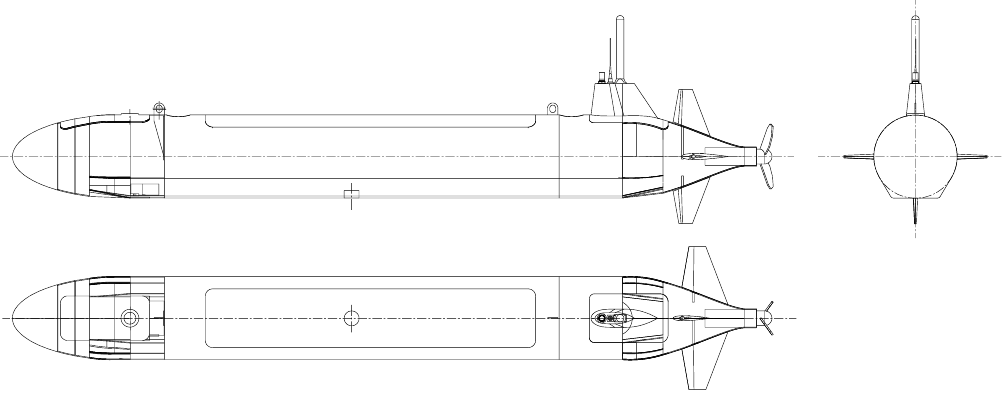
Figure 3. Three views of the target AUV to be docked.